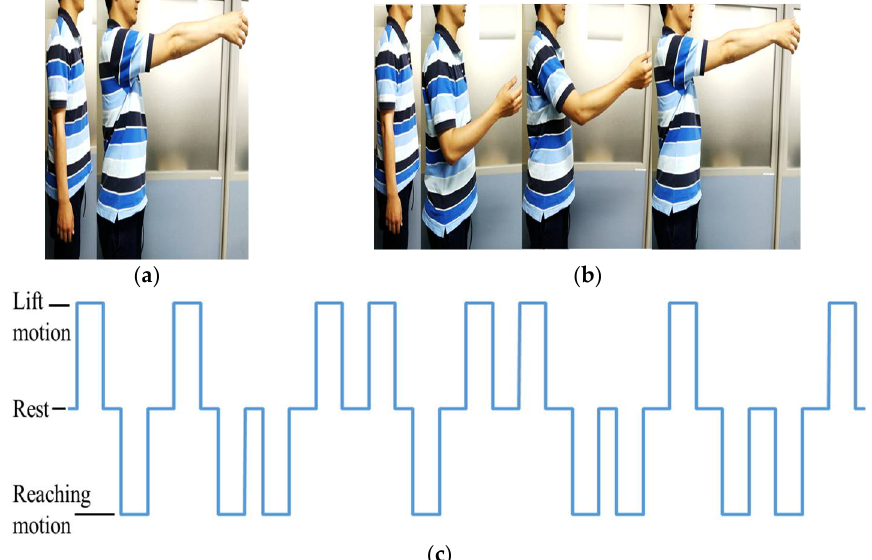
Figure 4. Motions used in the experiment. ( a ) Arm lifting; ( b ) Hand reaching; ( c ) Motion schedule (1 = arm lifting motion, 0 = rest, −1 = hand reaching motion).